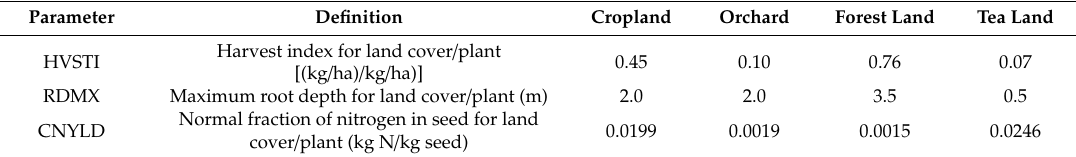
Table 1. Comparison of key Soil and Water Assessment Tool (SWAT) parameter values derived for tea with those available for other crops grown in the